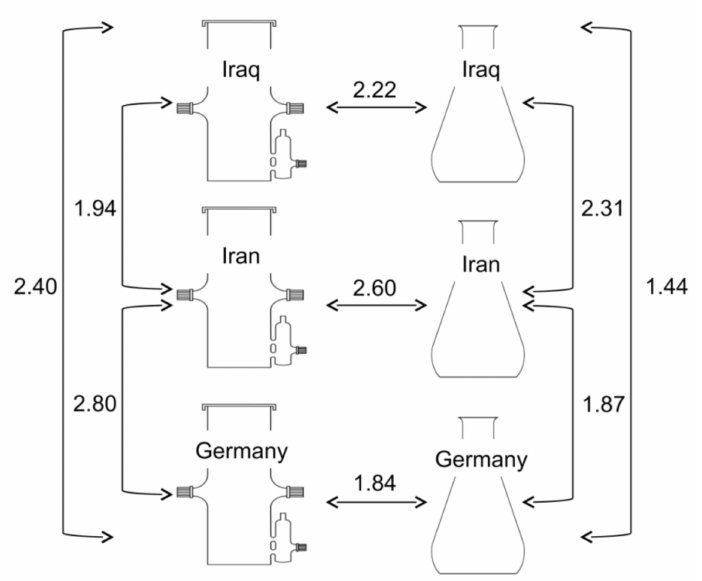
Figure 10. Euclidean distances between normalized metabolic profiles of hairy root exudates obtained from three accessions of Hyoscyamus niger (designated Iraq, Iran and Germany) grown in bioreactors and flask